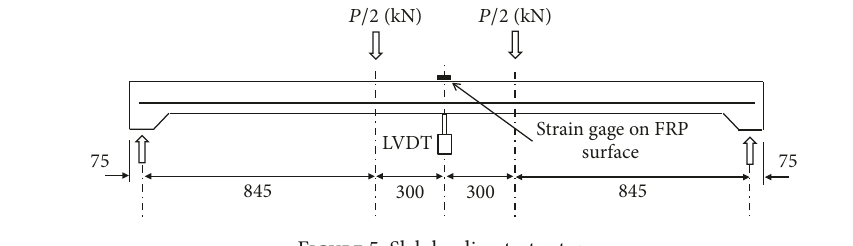
Figure 5: Slab loading test setup.